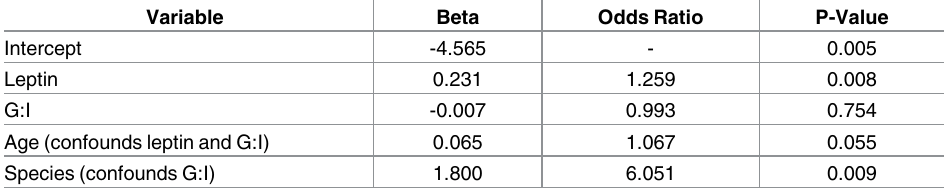
Table 8. Leptin and the glucose-to-insulin ratio (G:I) in predicting cyclicity status using repeatedmea- sures logistic